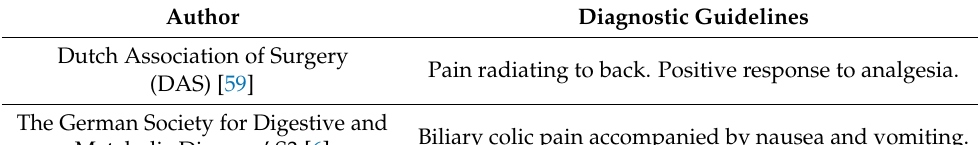
Table 1. Guidelines describing biliary colic.